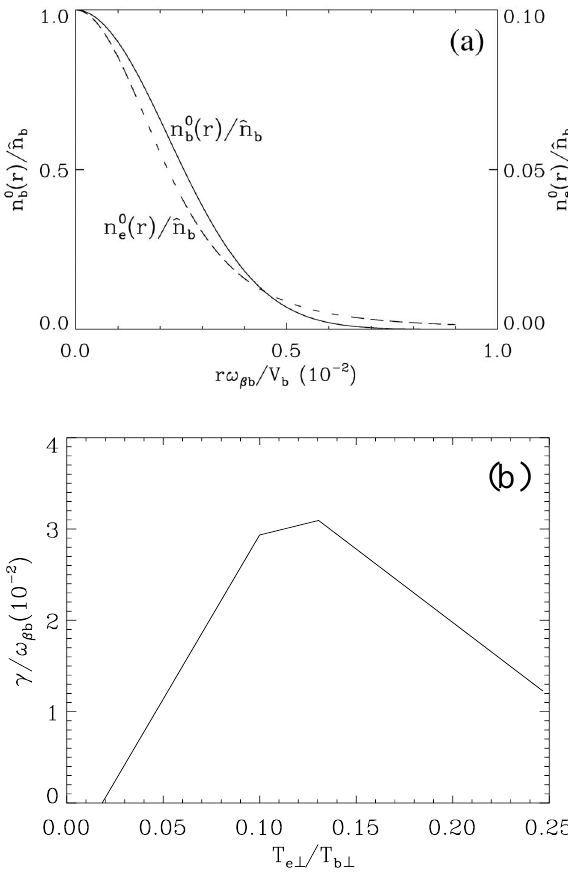
FIG. 4. Plots of the linear growth rate g (cid:1) Im v ,